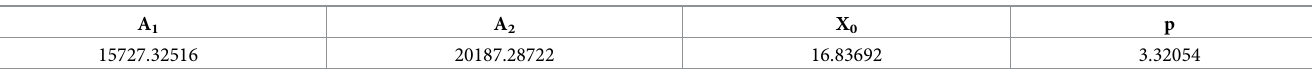
Table 11. Fitting equation parameters of spatial accessibility of 65–38. A